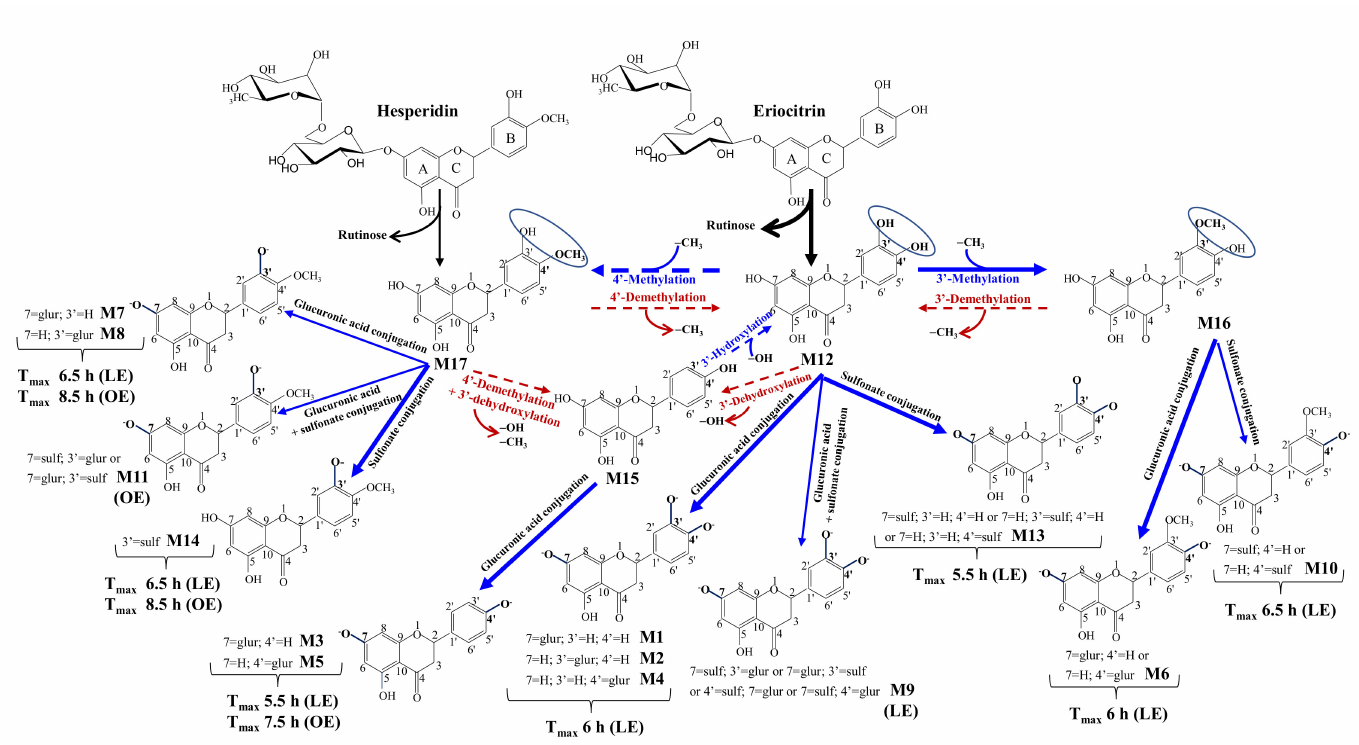
Figure 4. Main metabolic transformations of hesperidin and eriocitrin to their corresponding phase-II conjugates. The identification and quantification of metabolites (M) can be found in Tables 3 and 4, respectively. The pharmacokinetic values can be found in Table 5. Black lines, microbial metabolism; blue lines, phase-II metabolism; red lines, phase-I or microbial metabolism; dashed lines, proposed new metabolic steps in the human metabolism of hesperidin and eriocitrin. The thickness of the lines represents the most favored pathways. LE, lemon extract; OE, orange extract (hesperidin); glur, glucuronic acid; sulf, sulfonic acid. The formation of eriodictyol ( M12 ) from hesperetin mainly occurs via 4 (cid:48) -demethylation of hesperetin ( M17 ) and the formation of naringenin ( M15 ), after 4 (cid:48) -demethylation plus 3 (cid:48) -dehydroxylation. Besides, M12 could also be formed after CYP-catalyzed 3 (cid:48) -hydroxylation of M15 (Figure 4). These steps were supported by the detection of eriodictyol and naringenin conjugates after hesperidin intake in plasma and urine. However, no homoeriodictyol or derived metabolites ( M16 , M6 , M10 ) were observed after hesperidin intake, which indicates that 4 (cid:48) -methylation to yield back hesperetin was favored instead of the subsequent 3 (cid:48) -methylation of eriodictyol to yield homoeriodictyol after consuming hesperidin (Figure